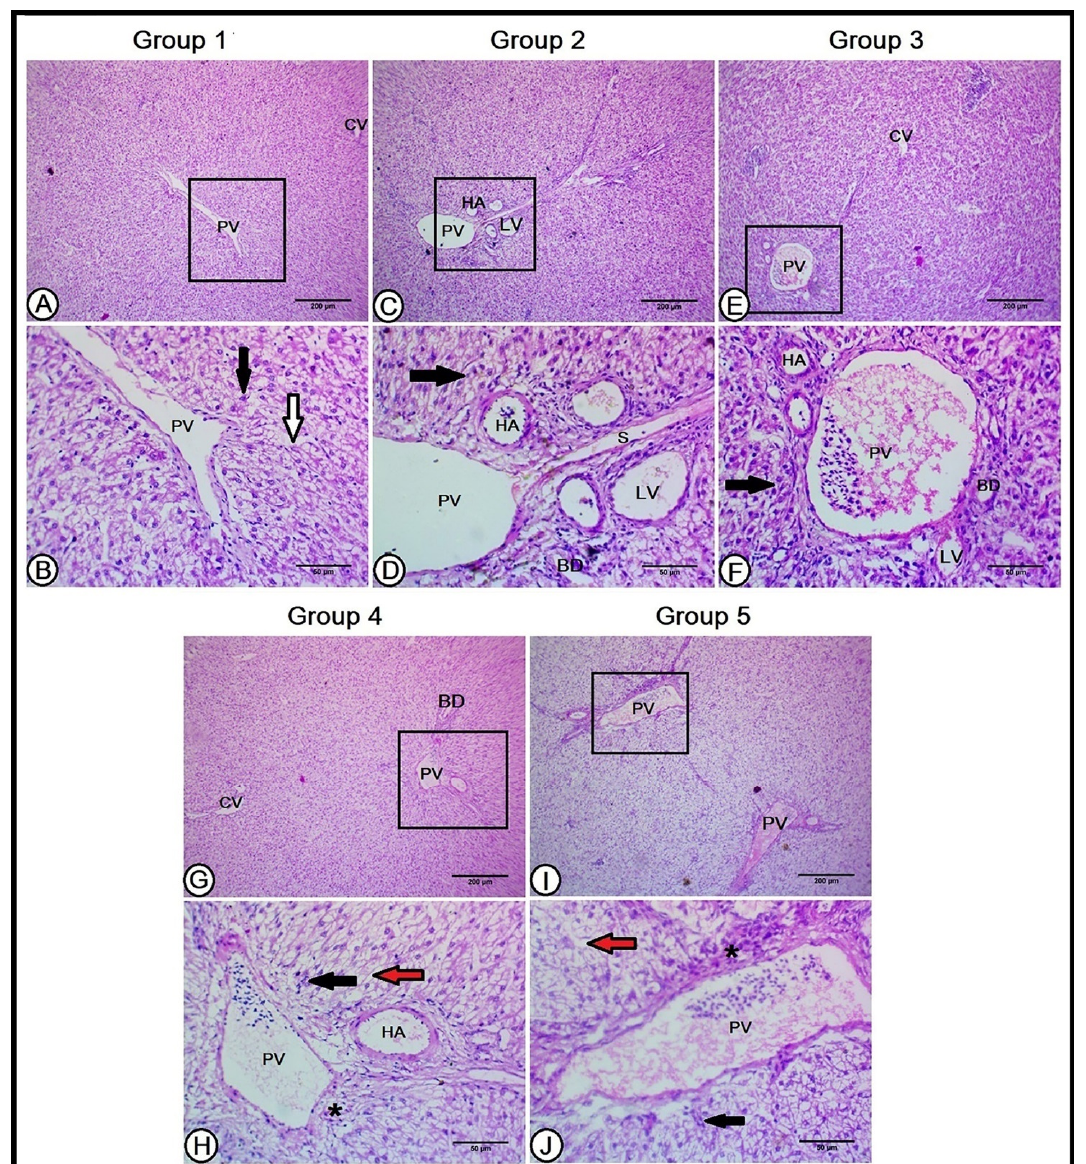
Figure 1. A histopathological analysis of the hepatic architecture in the experimental groups ( A , B ): the livers in the first group (Con) showed normal hepatic architecture. The central vein (CV) was in the center of each hepatic lobule and the hepatocytes (black arrow) were arranged in plates that radiate longitudinally outward from the central vein that was separated by a hepatic sinusoid (white arrow). The portal triad contained a branch of the portal vein (PV). The livers of the second and third groups ( C – F , respectively) revealed a better organization of the hepatic cells (black arrows) and hepatic sinusoid (S) in between. The portal triad is composed of a large-sized branch of the portal vein (PV), with numerous branches of the hepatic artery (HA), and bile ducts (BD), in addition to lymphatic tissues (LV). The livers in the fourth and fifth groups ( G – J , respectively) illustrate disorganized and degenerated hepatocytes (black arrows) around the central vein (CV), numerous variable-sized hepatic sinusoids (red arrows), excessive connective tissue, lymphocytic infiltration (black asterisks), fewer branches of the hepatic artery (HA), and bile duct